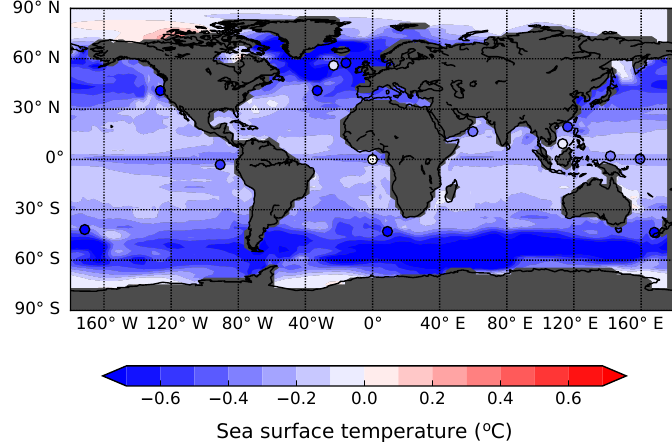
Figure 14. Annual sea surface temperature difference ( ◦ C) between the average of the pre-MBE (MIS 13, 15, 17, 19) and post-MBE (MIS 5, 7, 9, 11) interglacials with interactive vegetation and different ice sheets (OVIC). The vertical black line indicates the limit between the Southern Ocean south of 32 ◦ S and the Atlantic Ocean north of 32 ◦ S. The dots are SST data differences based on the Past Interglacials Working Group of PAGES (2016) (Table